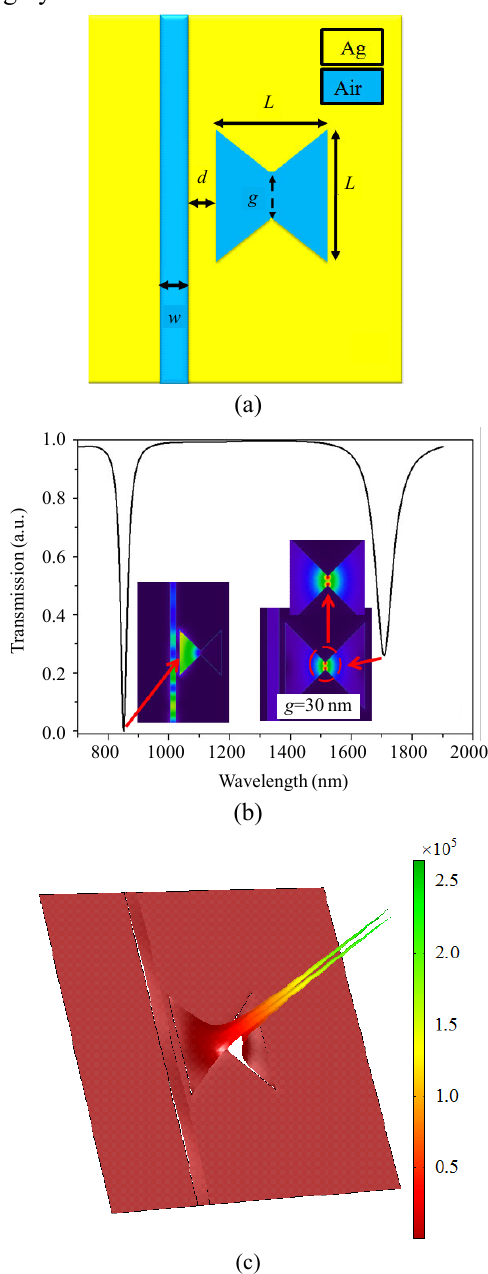
Fig. 1 Schematic and E-field distribution: (a) standard BT scheme, (b) transmission spectrum of a BT resonator at n =1.0 (inset shows the E-field distribution of two resonant dips), and (c) 3D electric field intensity distribution in the cavity at the resonance